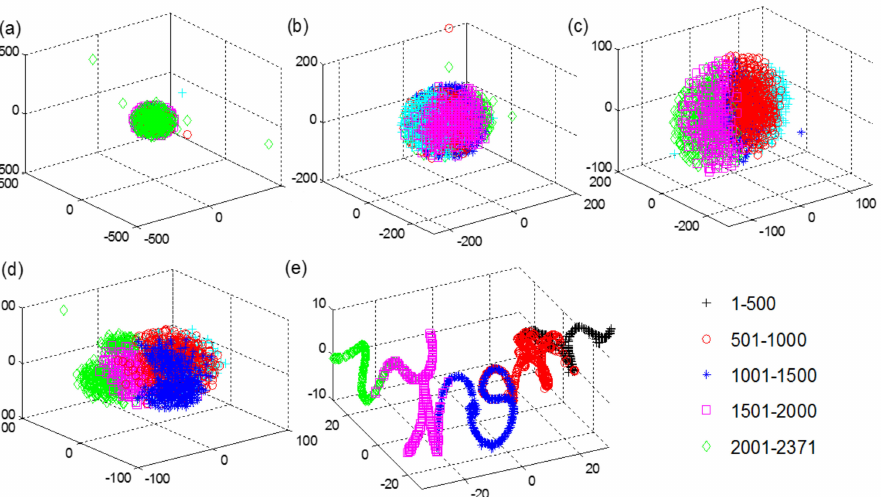
Figure 15. Visualization results of the different layers for the ConvLSTM. ( a ) Network input; ( b ) Con- vLSTM1 layer; ( c ) ConvLSTM2 layer; ( d ) ConvLSTM3 layer; ( e ) FC2